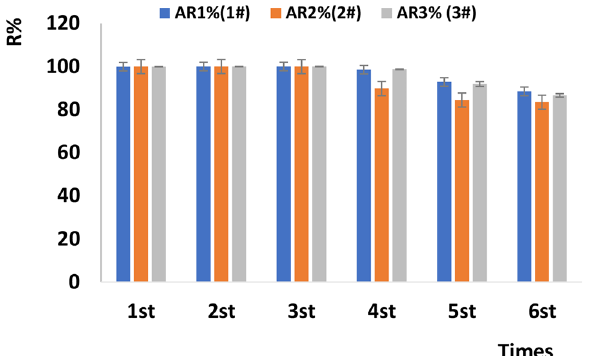
Figure 2. Results of adsorbent regenerability